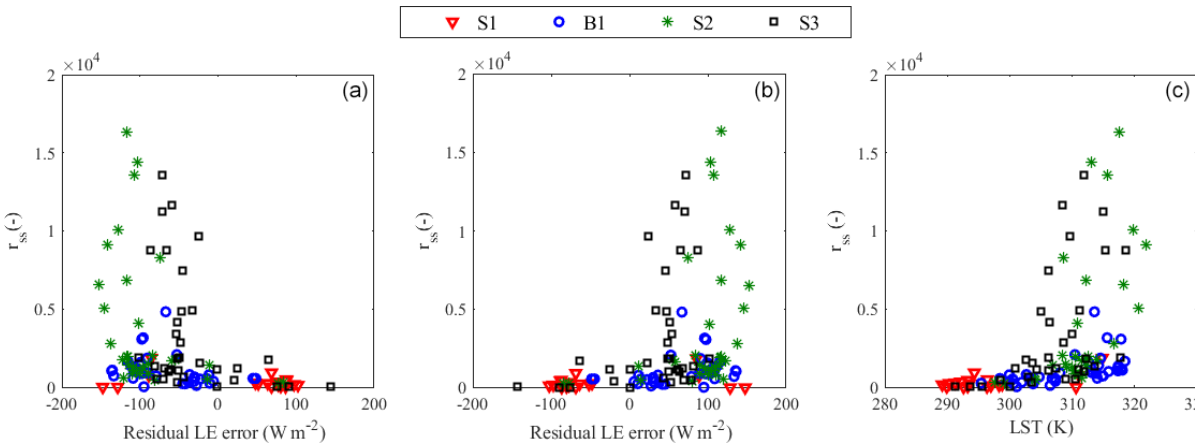
Figure 13. Retrieved r ss vs. residual H (a) and LE (b) error and LST (c) for the four study periods separately.